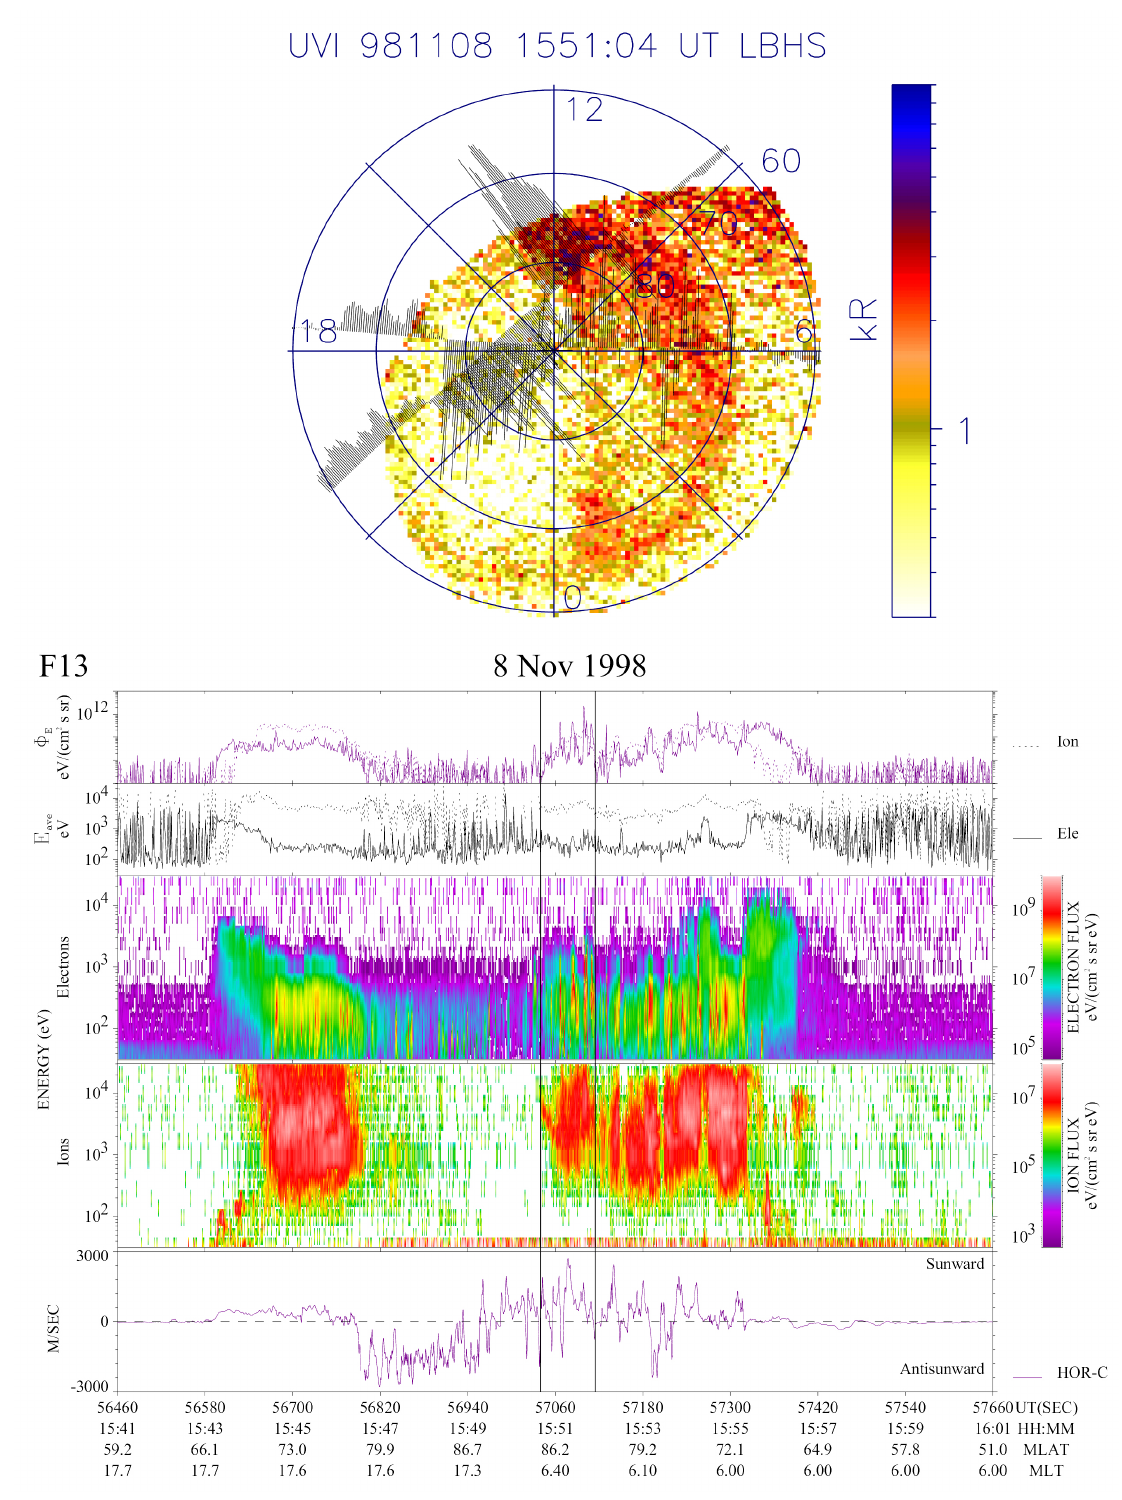
Fig. 6. Data shown from the third DMSP pass on 8 November 1998 (15:41–16:01 UT), which occurs during the UVI data period. Same format as Fig. 4. See text for